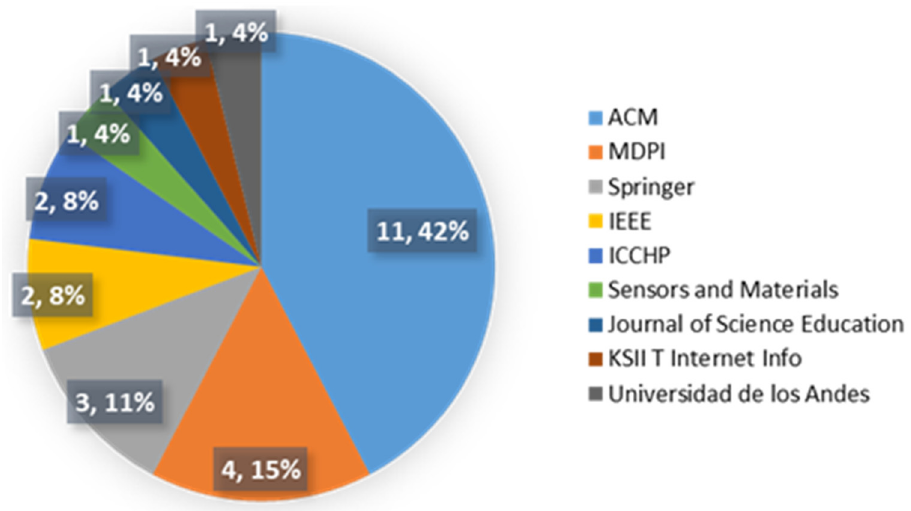
Figure 6. Number of selected papers according to electronic database and digital library or open-access publisher.